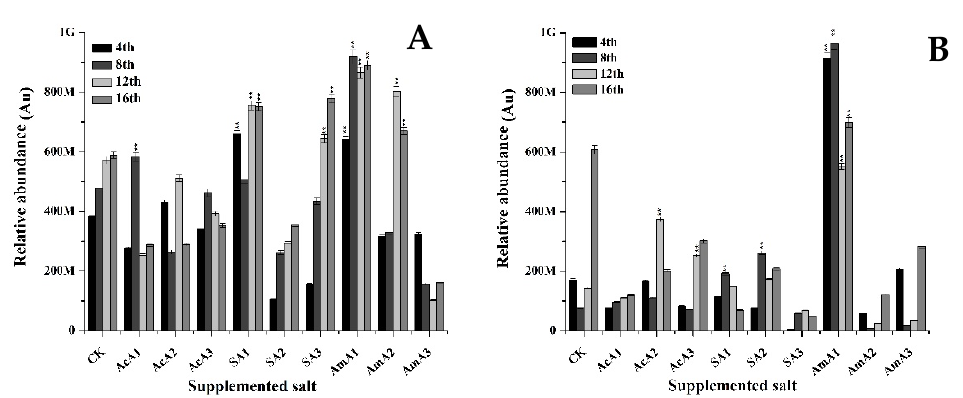
Figure 3. Monascin value of M. ruber M7 grown over PDA spiked with acetic acid, sodium acetate and ammonium acetate at different concentrations. Acetic acid: AcA1: 0.1%, AcA2: 0.25%, AcA3: 0.5%; Sodium acetate: SA1: 0.1%, SA2: 0.25%, SA3: 0.5%; Ammonium acetate: AmA1: 0.1%, AmA2: 0.25%, AmA3: 0.5%; CK: Control. Error bars show the standard deviation among the treatments. **: